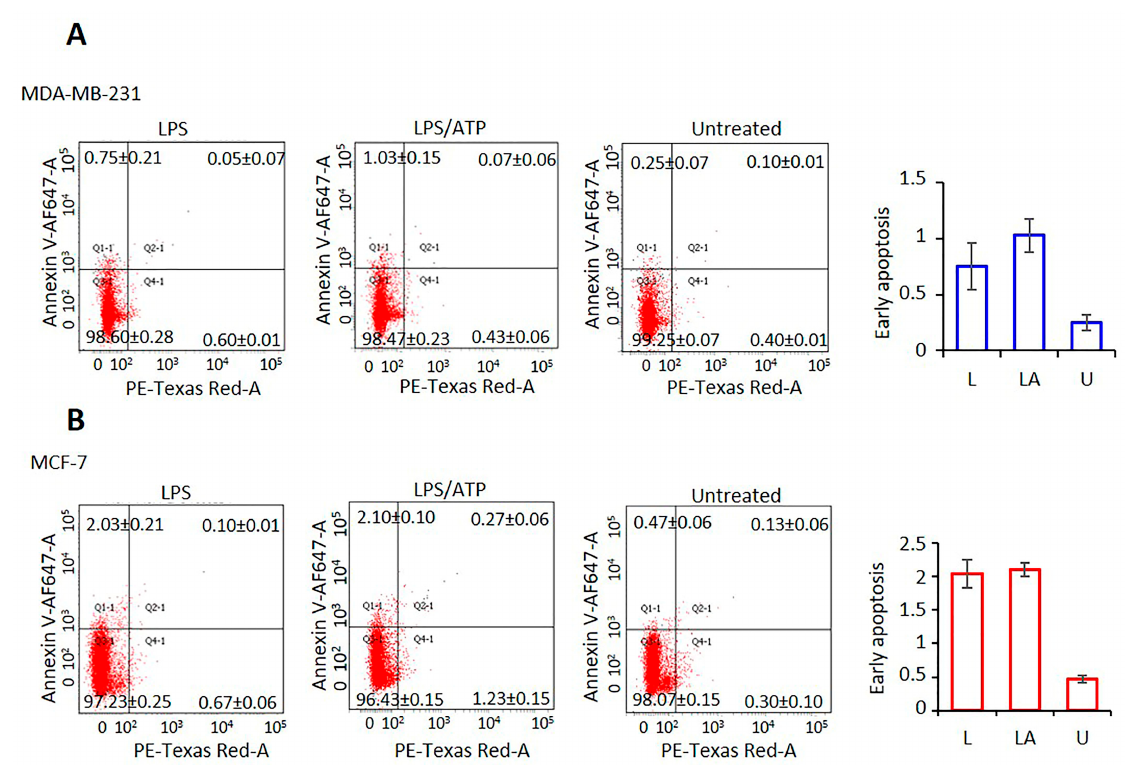
Figure 4. The effect of NLRP3 activation on cell death in MDA-MB-231 and MCF-7 cells. Cells were incubated with LPS (1 µ g/mL, 3 h) to activate NLRP3 followed by ATP treatment (5 mM ATP; 25 min) to form an inflammasome complex. Images were analyzed using FlowJo software. ( A ) MDA-MB-231 cells; ( B ) MCF-7 cells. L: LPS only, LA: LPS/ATP, U: untreated. p value was calculated using the one ‐ way ANOVA model with Tukey’s post hoc tests. Data represent three technical repeats.